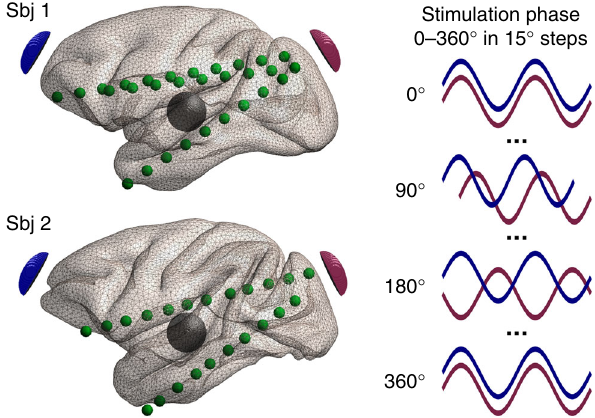
Fig. 1 Experimental design. Two nonhuman primates with recording electrodes implanted along the anterior-posterior plane receive transcranial electric stimulation (TES). For subject 1 we analyze three recording electrodes with 29 contacts altogether, and for subject 2 — two recording electrodes with 22 contacts. Two TES stimulation electrodes are placed on the scalp at anterior (blue) and posterior (red) locations, with the return electrode (black) over the temporal area. Alternating current stimulation was applied at 10Hz and fi xed intensity at the stimulation electrodes, while the phase of the stimulation currents between them varied from 0° to 360° in 15° steps (25 phase conditions in total). See Supplementary Movie 1 for a 3D